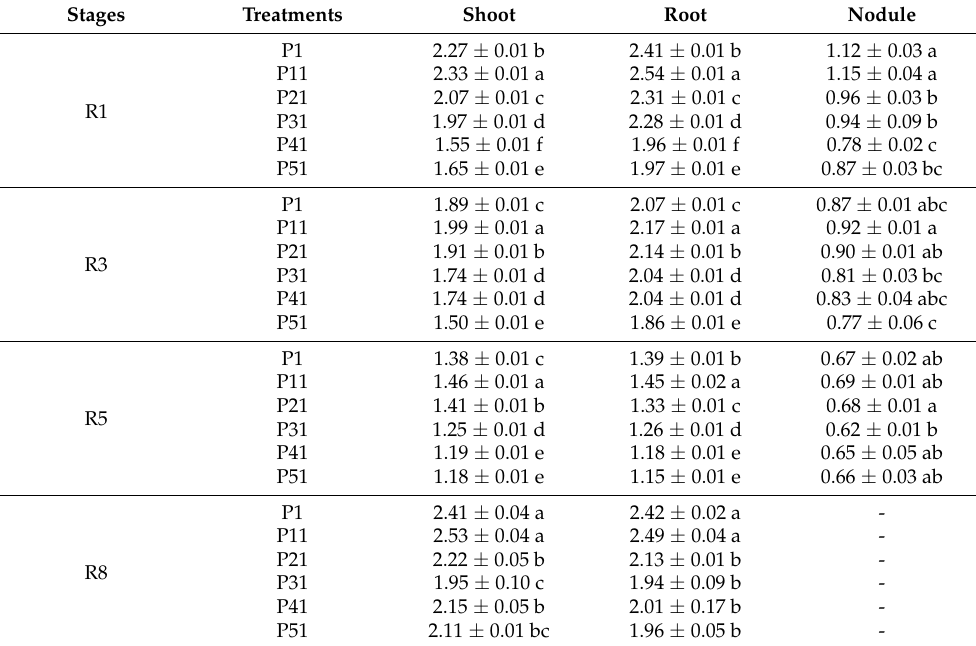
Table 3. 15 N abundance (%) in plant organs of soybean under different phosphorus supply levels.